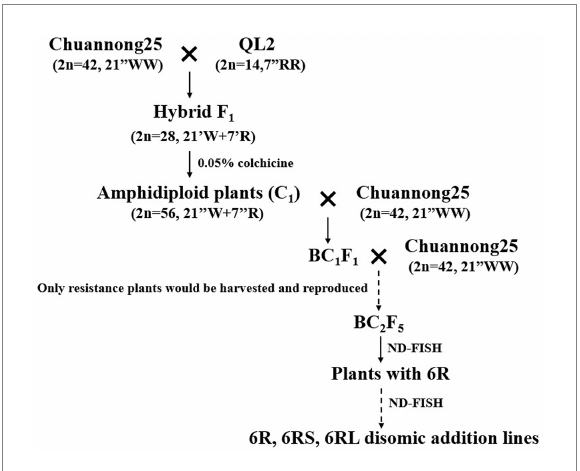
FIGURE 1 The pedigree of the new 6R, 6RS, and 6RL addition lines.